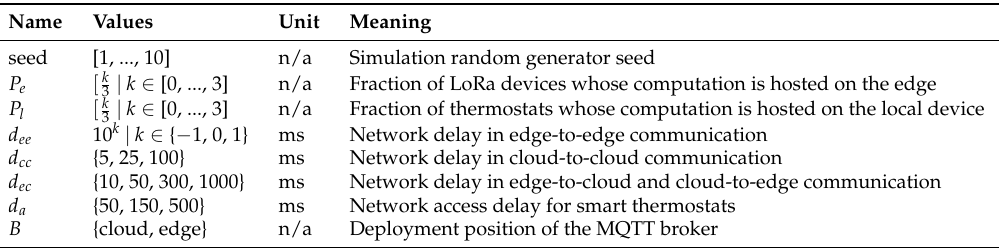
Table 3. Free variables for the case.